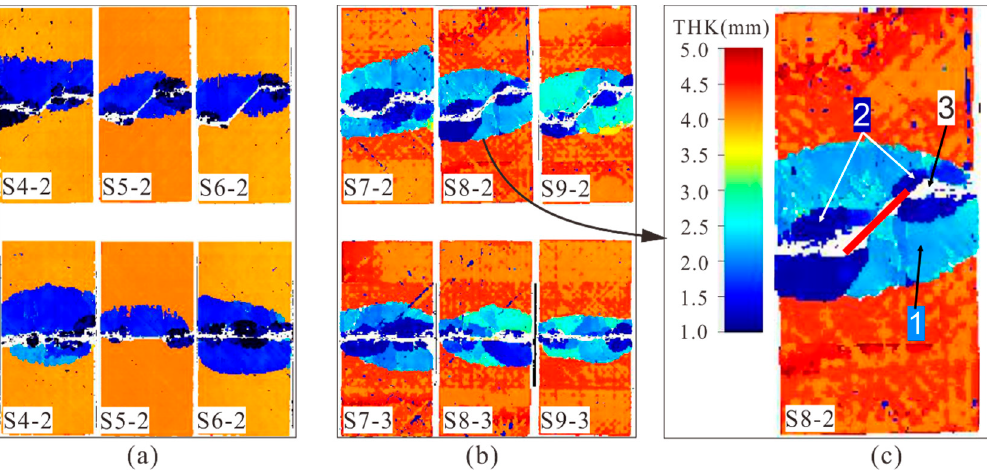
Figure 14. C-scan results of specimens after compression failure, ( a ) specimens with medium cracks, ( b ) deep cracks, and ( c ) typical results of S8-2.